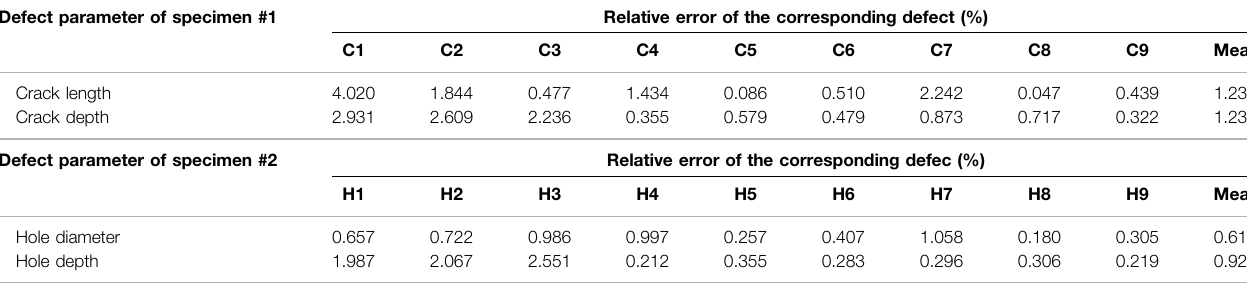
TABLE 4 | Relative error of the defect evaluation of deep belief network – least squares support vector machine. Defect parameter of specimen #1